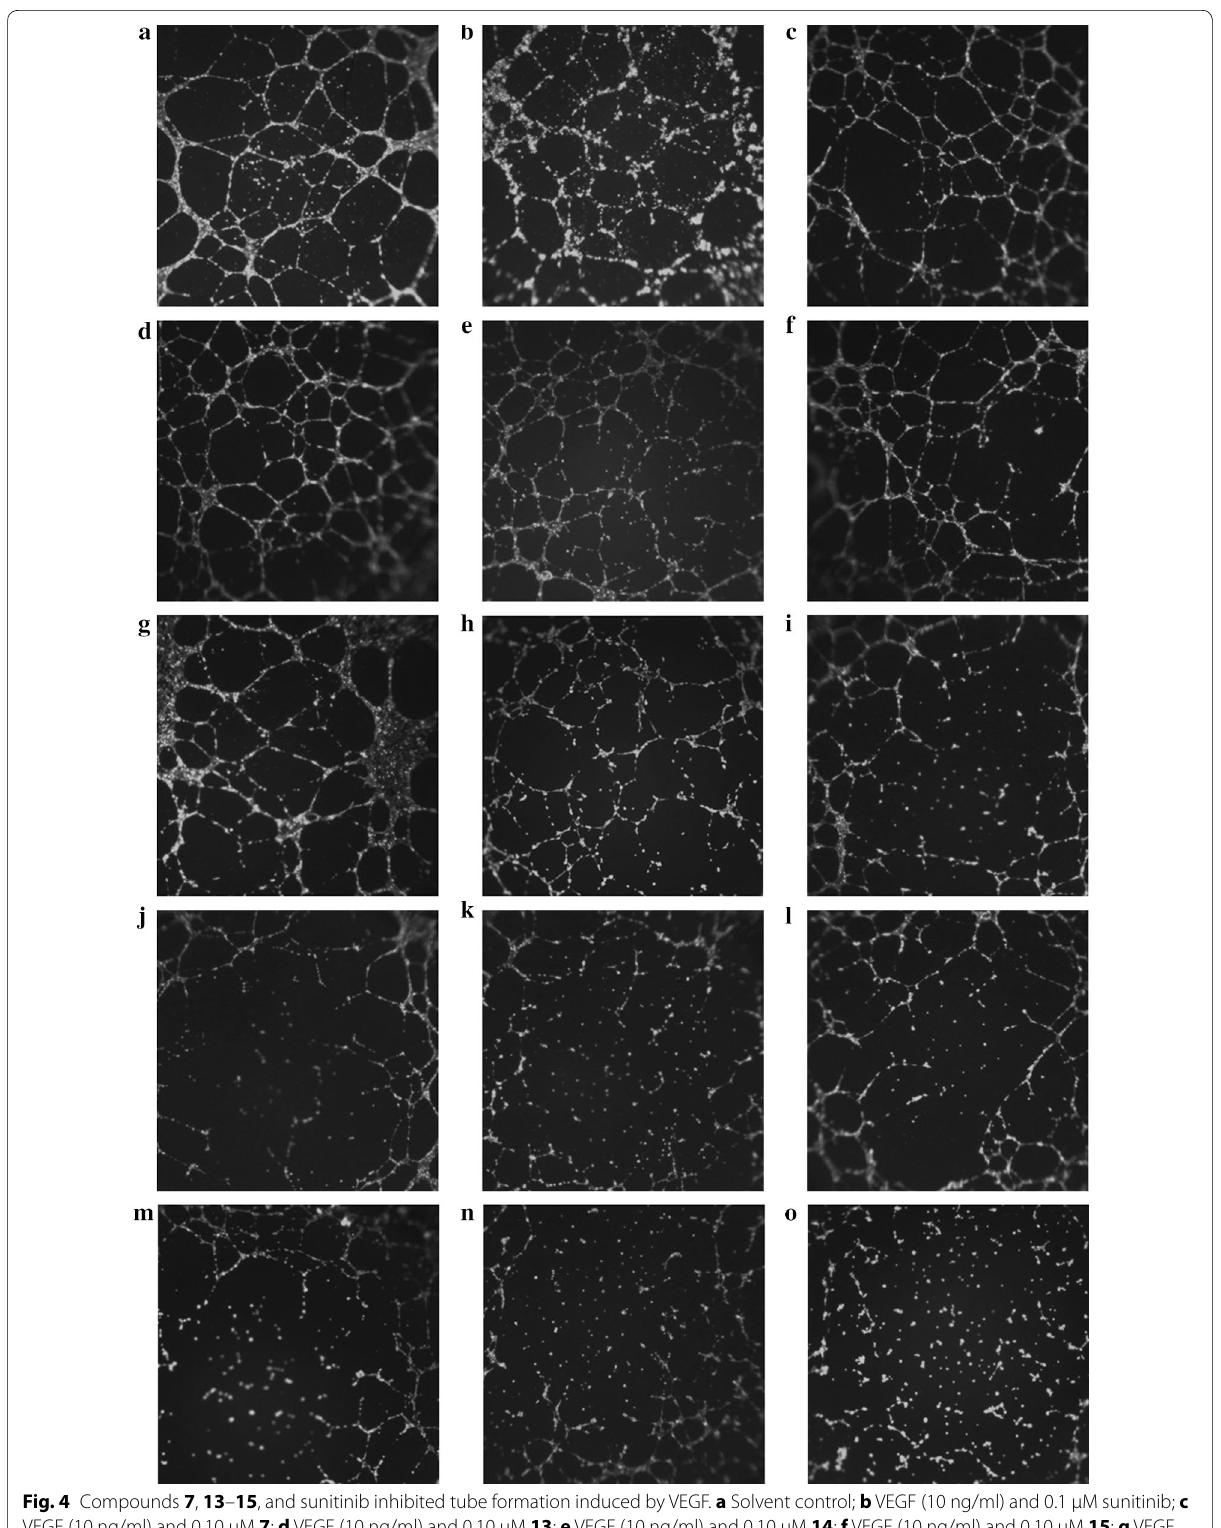
Fig. 4 Compounds 7 , 13 – 15 , and sunitinib inhibited tube formation induced by VEGF. a Solvent control; b VEGF (10 ng/ml) and 0.1 μM sunitinib; c VEGF (10 ng/ml) and 0.10 μM 7 ; d VEGF (10 ng/ml) and 0.10 μM 13 ; e VEGF (10 ng/ml) and 0.10 μM 14 ; f VEGF (10 ng/ml) and 0.10 μM 15 ; g VEGF (10 ng/ml) and 0.50 μM sunitinib; h VEGF (10 ng/ml) and 0.50 μM 7 ; i VEGF (10 ng/ml) and 0.50 μM 13 ; j VEGF (10 ng/ml) and 0.50 μM 14 ; k VEGF (10 ng/ml) and 0.50 μM 15 ; l VEGF (10 ng/ml) and 1.0 μM sunitinib; m VEGF (10 ng/ml) and 1.0 μM 7 ; n VEGF (10 ng/ml) and 1.0 μM 13 ; o VEGF (10 ng/ml) and 1.0 μM